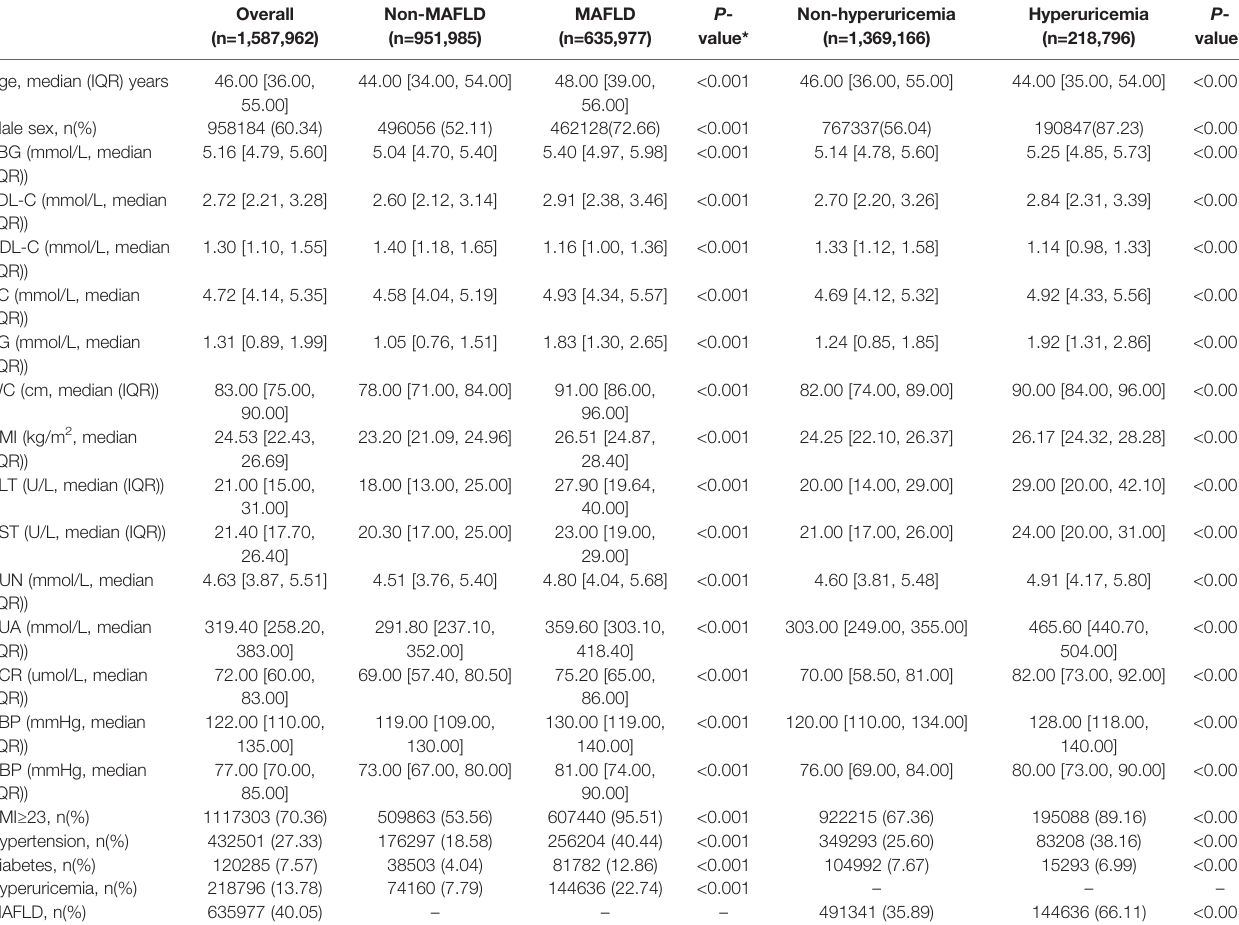
TABLE 1 | Baseline characteristics of 1,587,962 participants strati fi ed by MAFLD and hyperuricemia in the sectional study. Overall